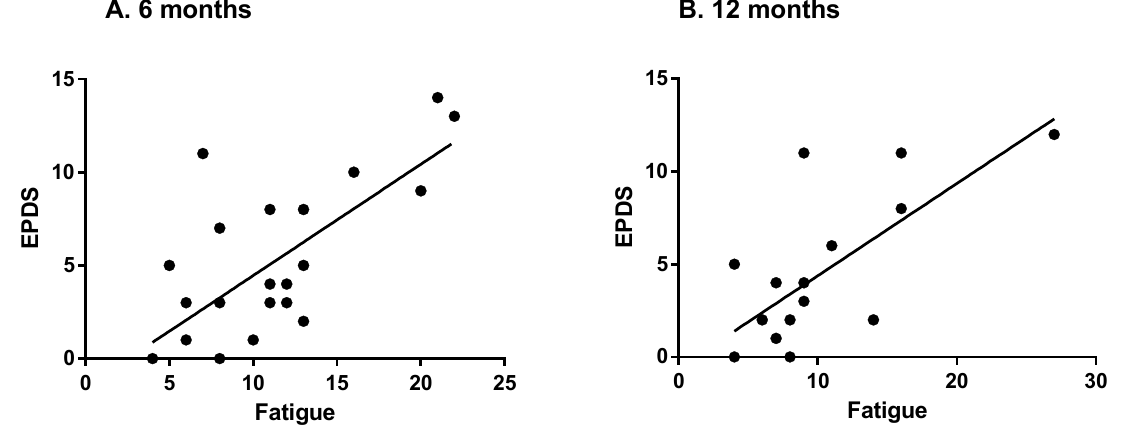
Figure 3. EPDS scores and fatigue at 6 months postpartum ( A ) and 12 months postpartum ( B ).